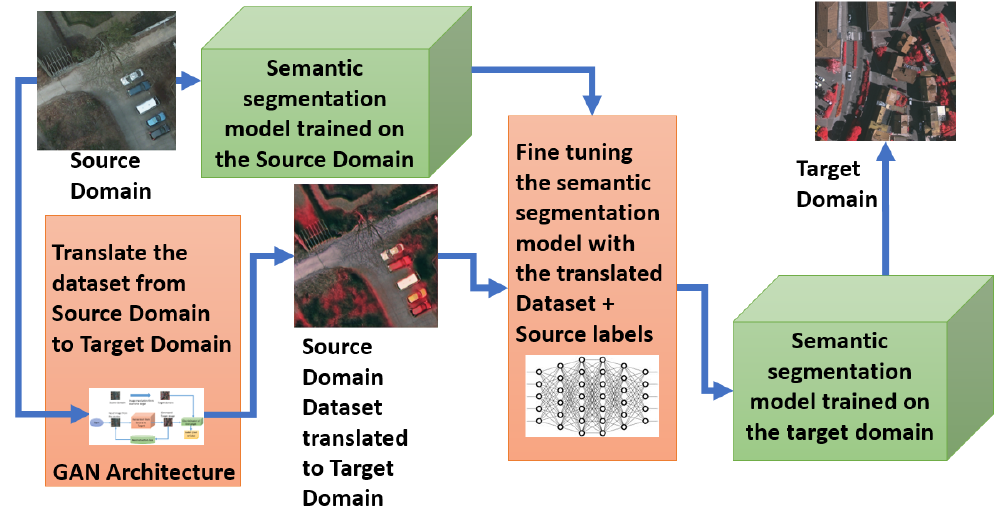
Figure 6. Flowchart of the domain adaptation